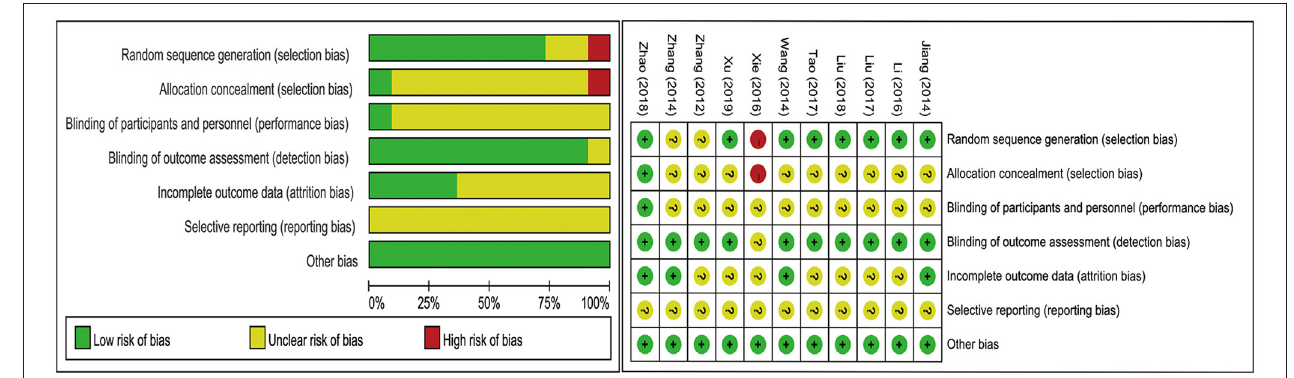
FIGURE 2 | Risk of bias